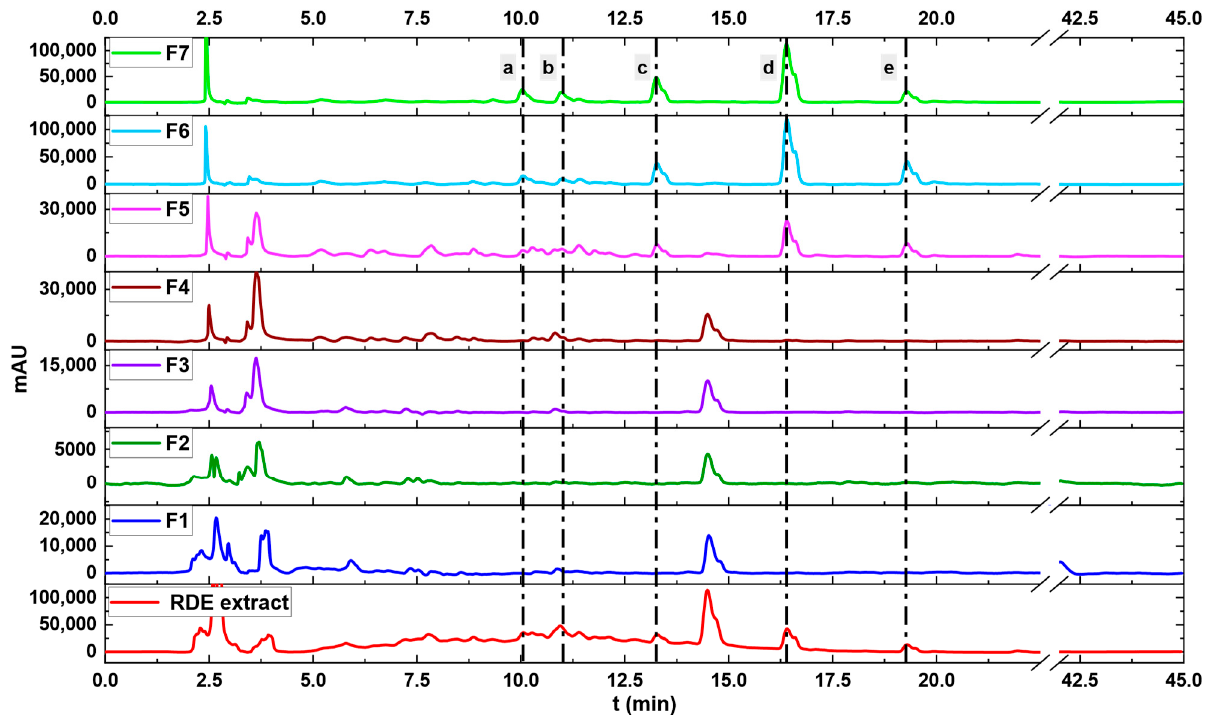
Figure 7. Fractions (F1 to F7) obtained after eluting the saturated MQ3 material. Table 2. Tentative identification of the phenolic compounds in the hydroethanolic extract of RDE. Peak Retention Time (min) Tentative Identification a 10.06 Myricetin-O-hexoside 10.9 Quercetin-o-hexuronoside 13.3 Myricetin 16.4 19.3